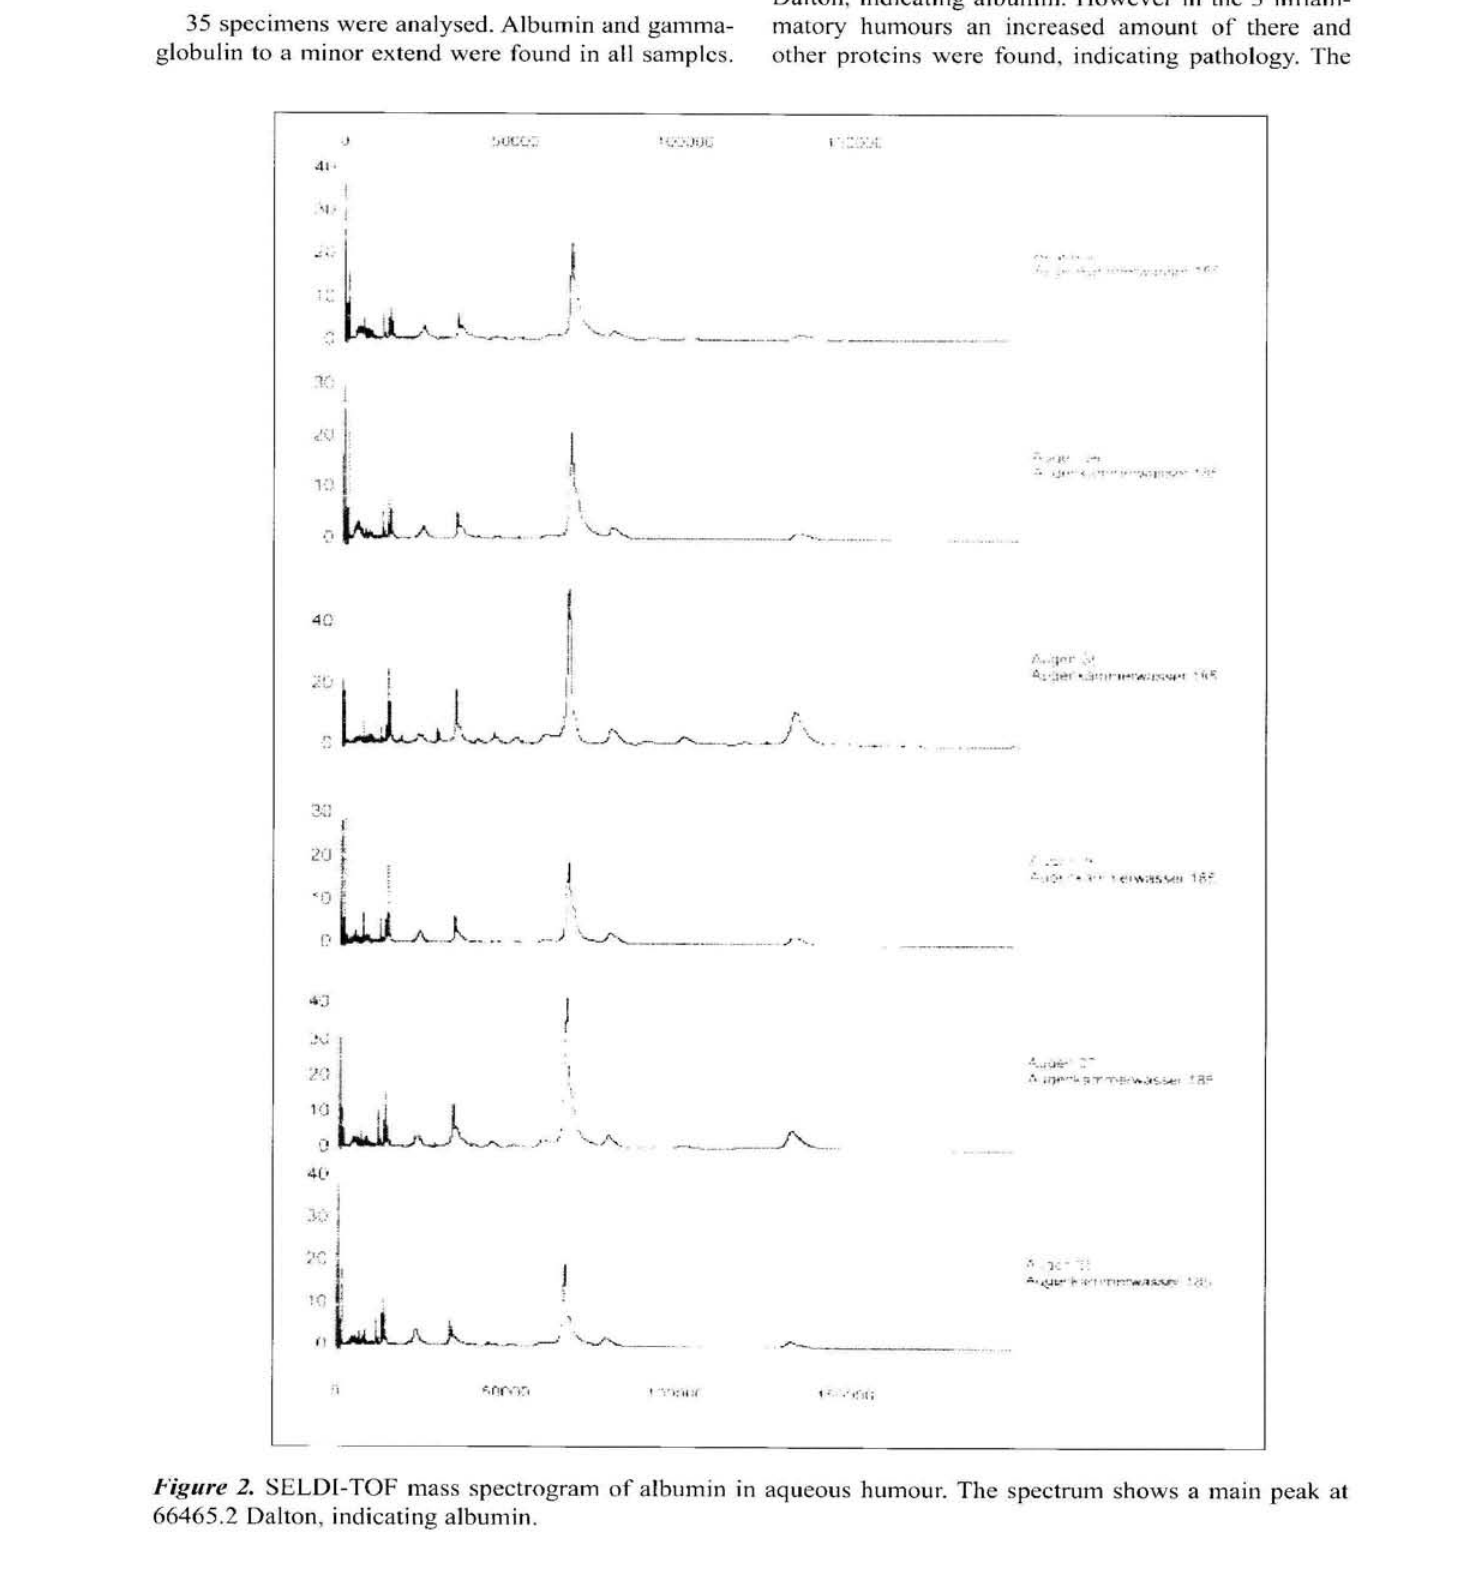
Figure 2. SELDI-TOF mass spectrogram of albumin in aqueous humour. The spectrum shows a main peak at 66465.2 Dalton, indicating